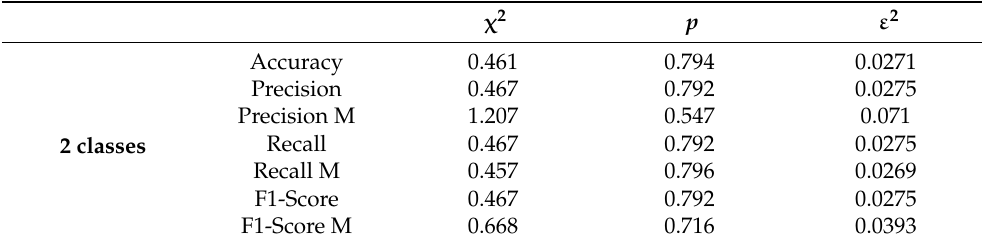
Table 4. Kruskal–Wallis analysis between MRMR and Chi-square feature selection methods, respec- tively, using 2 and 4 classes of